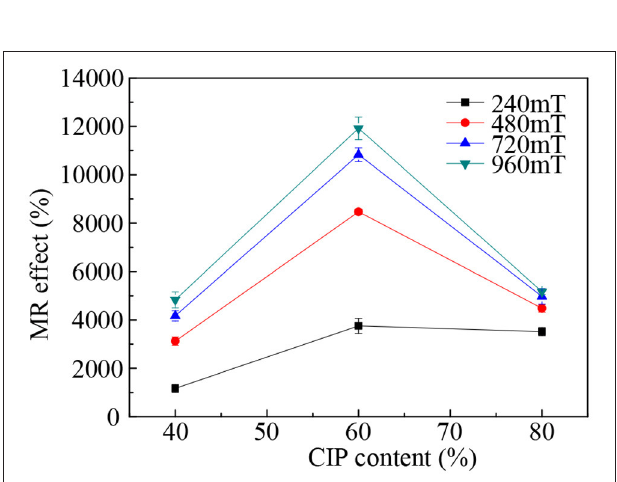
FIGURE 8 | The MR effect of the samples with different mass concentration of CIPs under different magnetic flux